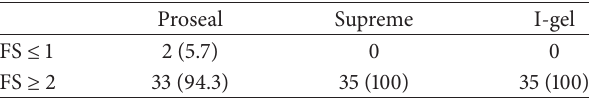
Table 3: Fiberoptic imaging classification.